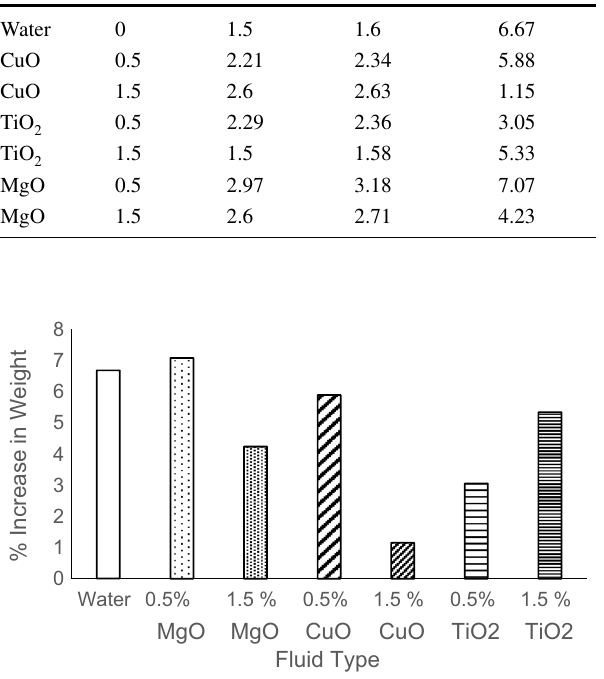
Fig. 6 % increase in wt for the different